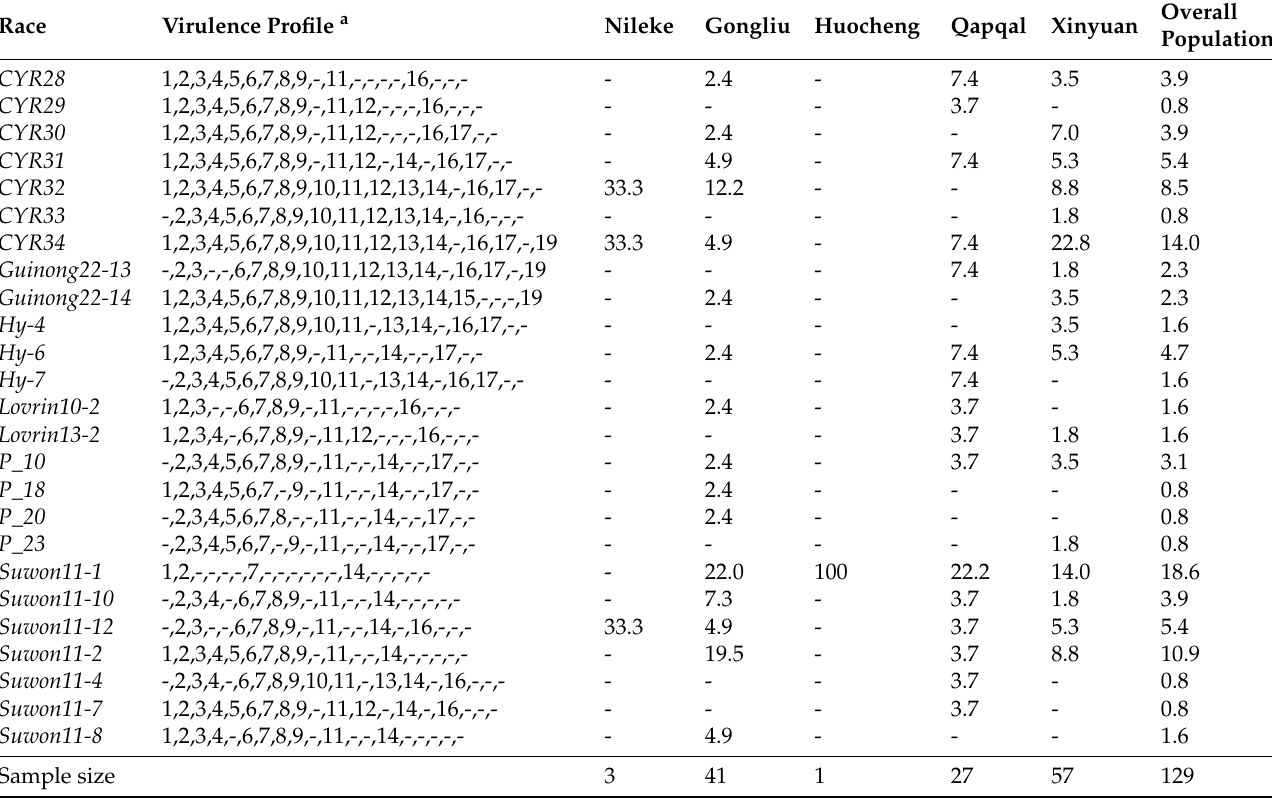
Table 4. Frequencies (%) of different races detected from Puccinia striiformis f. sp. tritici isolates collected from different locations in Xinjiang province of China in